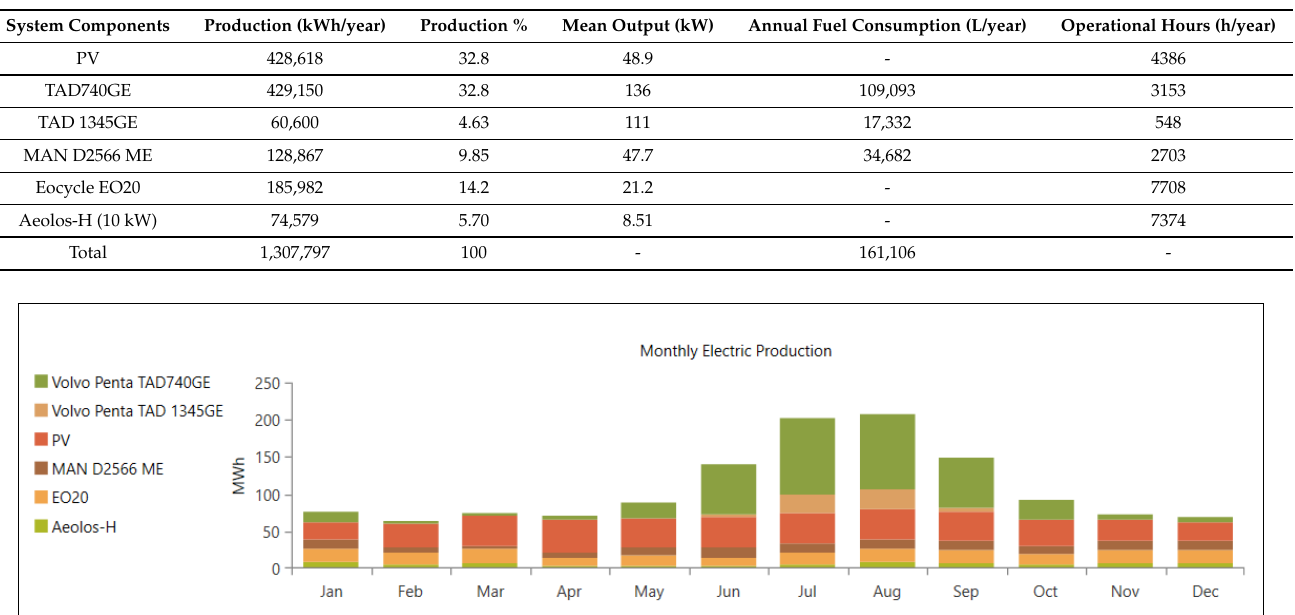
Figure 12. Monthly electrical production of each component of Scenario